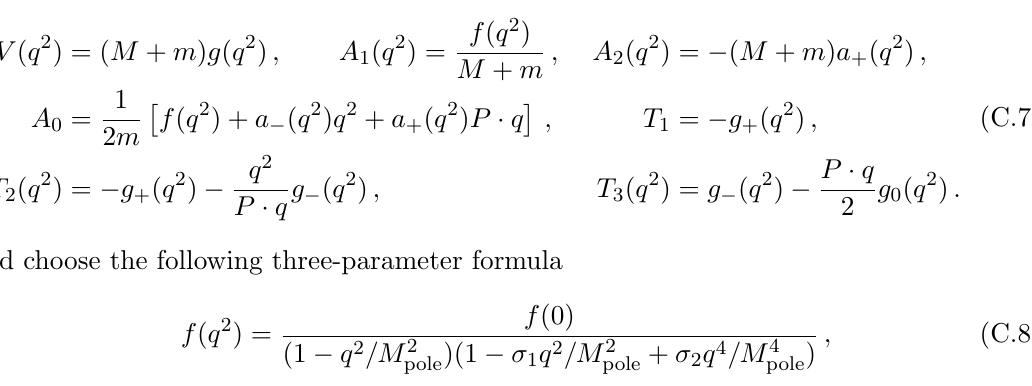
Table 14 . Part II: Best-(cid:12)t parameters values for eqs. (C.8){(C.9) from refs. [63, 129]. and follow the conventions of ref. [129], we de(cid:12)ne the following dimensionless